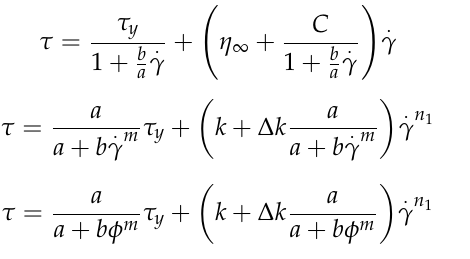
Figure A11. Teng model steady-state fitting.